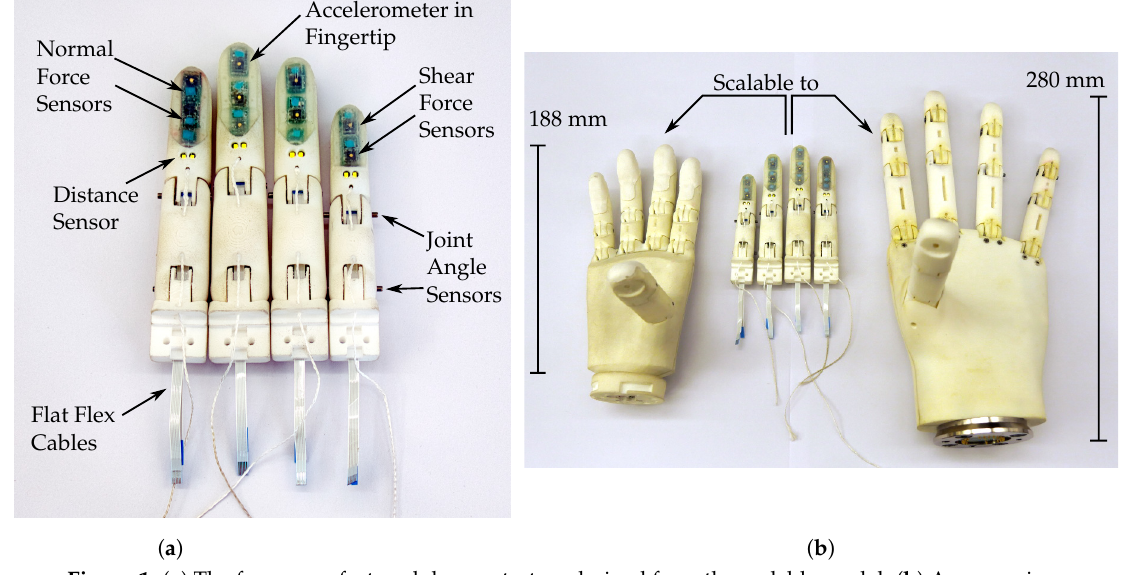
Figure 1. ( a ) The four manufactured demonstrators derived from the scalable model. ( b ) A comparison of the physical demonstrators with our most recent KIT Prosthetic Hand (left) and our robotic KIT ARMAR-6 Hand